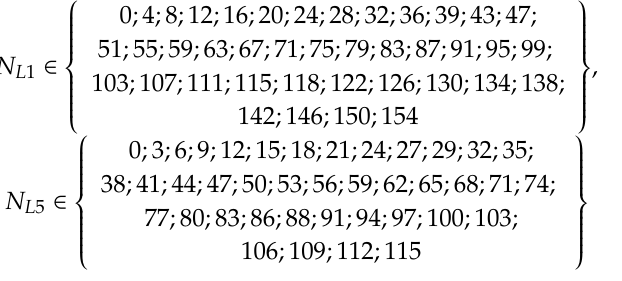
Figure 8. Behavior of the function Ψ ( N L 5 )